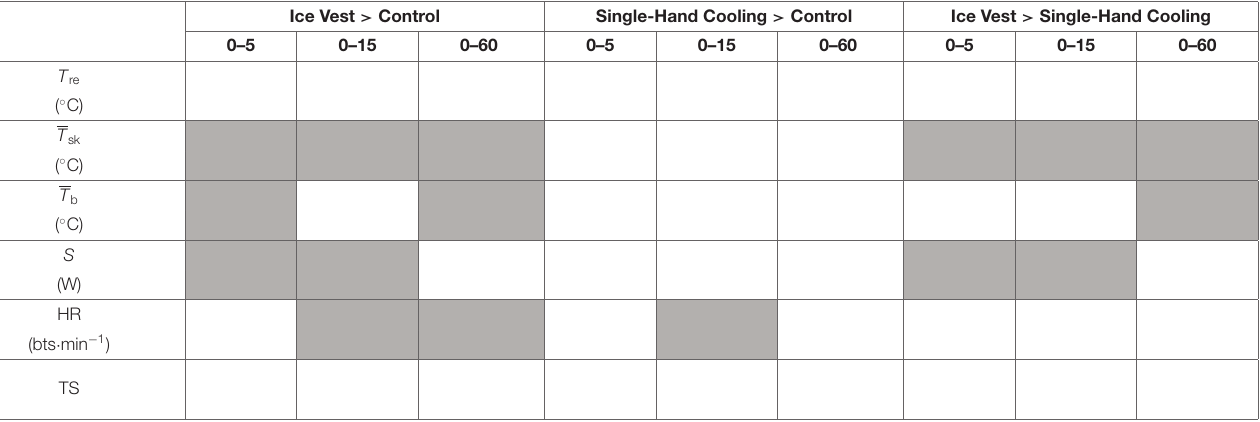
TABLE 2 | Visual summary of thermo-physiological and thermal perceptual differences between cooling conditions across immediate (REC 0 − 5 ), time-limited (REC 0 − 15 ), and prolonged recovery (REC 0 − 60 ).